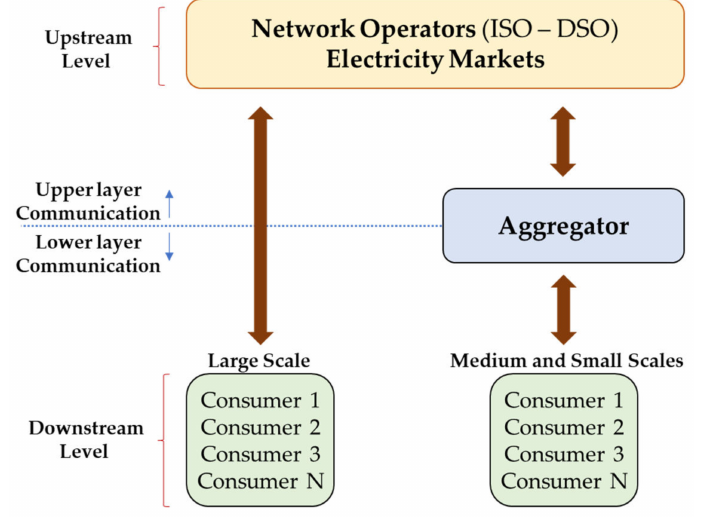
Figure 1. Participation of aggregator in the electricity system as a third-party